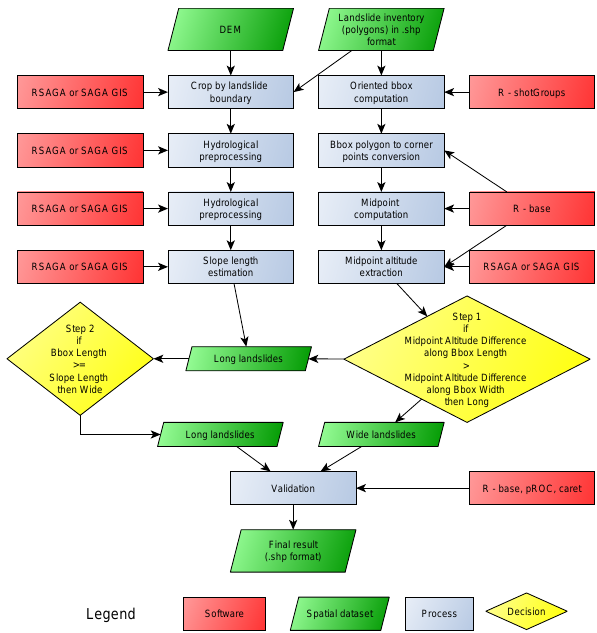
Figure 4. Workflow of the proposed algorithm implemented as an R script.